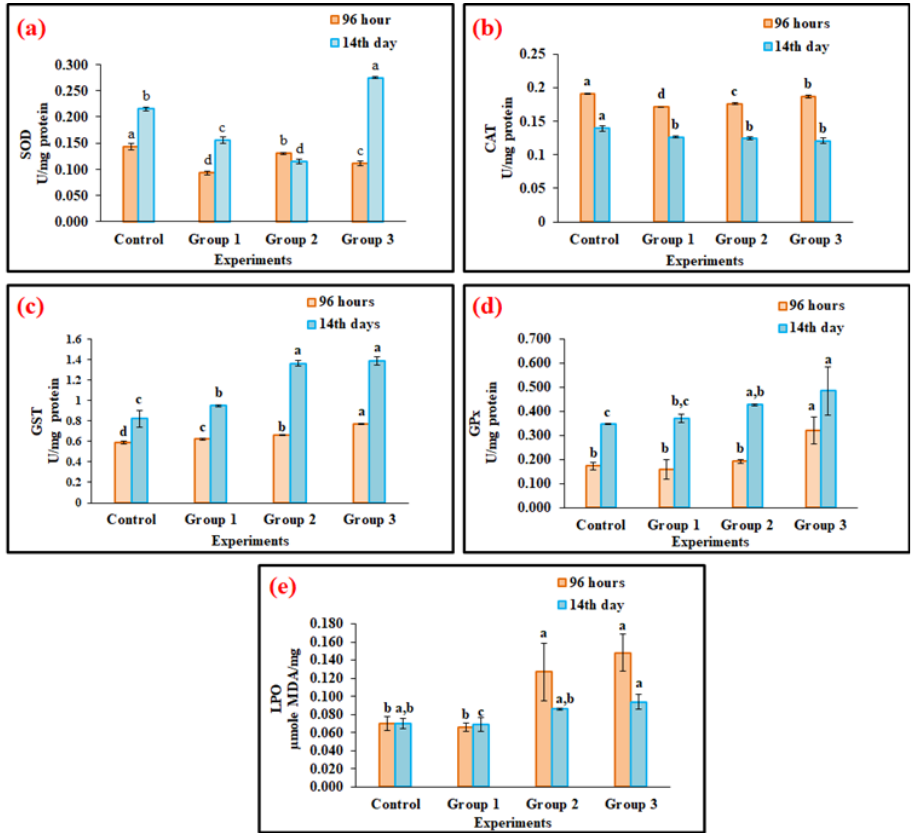
Figure 3. The antioxidant enzymes ( a ) Superoxide dismutase (SOD), ( b ) Catalase (CAT), ( c ) gluta- thione S-transferase (GST), ( d ) glutathione peroxidase (GPx) activities, and ( e ) oxidative stress ef- fects on lipid peroxidation (LPO) in the liver tissues of freshwater filter-feeding organisms Oreo- chromis mossambicus after 96 h and 14 days dietary exposed of polypropylene microplastics at dif- ferent concentrations (100 mg/kg (Group 1), 500 mg/kg (Group 2), 1000 mg/kg (Group3)). Statisti- cally significant differences ( p < 0.05) between experimental groups correspond to different alpha- bet letters. (Duncan’s multiple ranges test significant value p < 0.05).